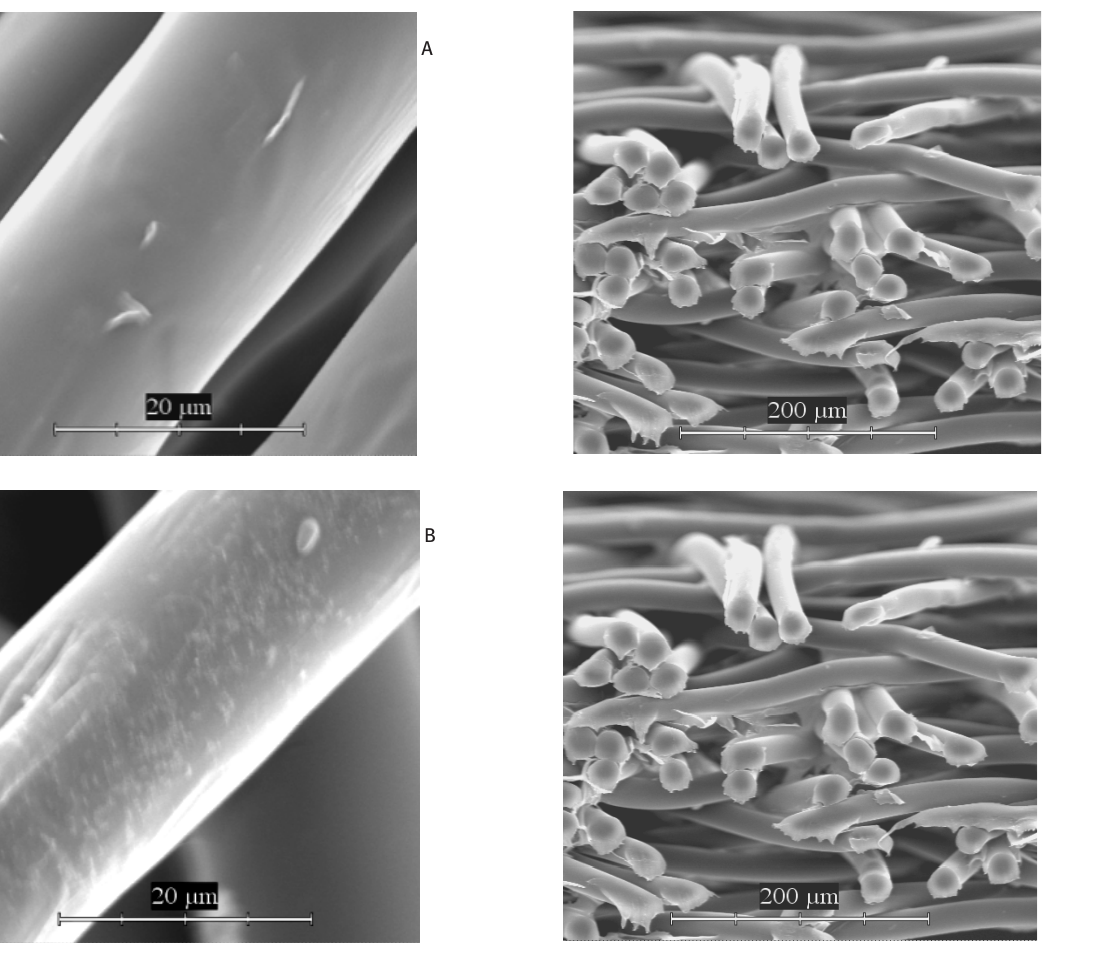
Figure 6: SEM images of cross sections of PP nonwoven fibres coated with chitosan layer.